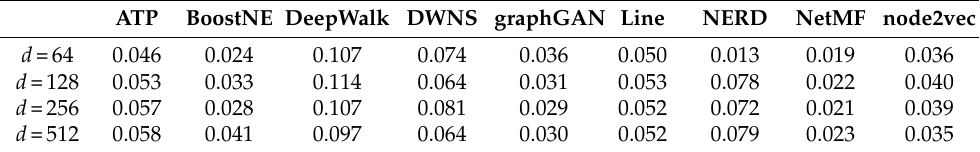
Table A3. Precision values of all embedding methods with the DBLP dataset and different values of d .